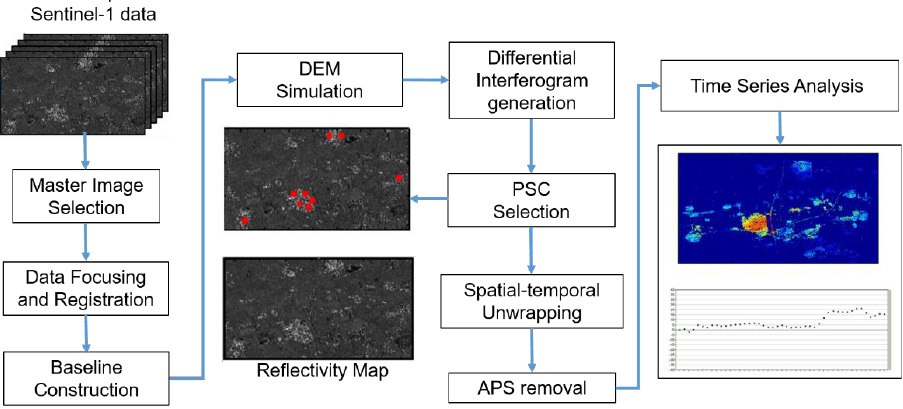
Figure 3. The framework of Sentinel-1 MT-InSAR analysis.